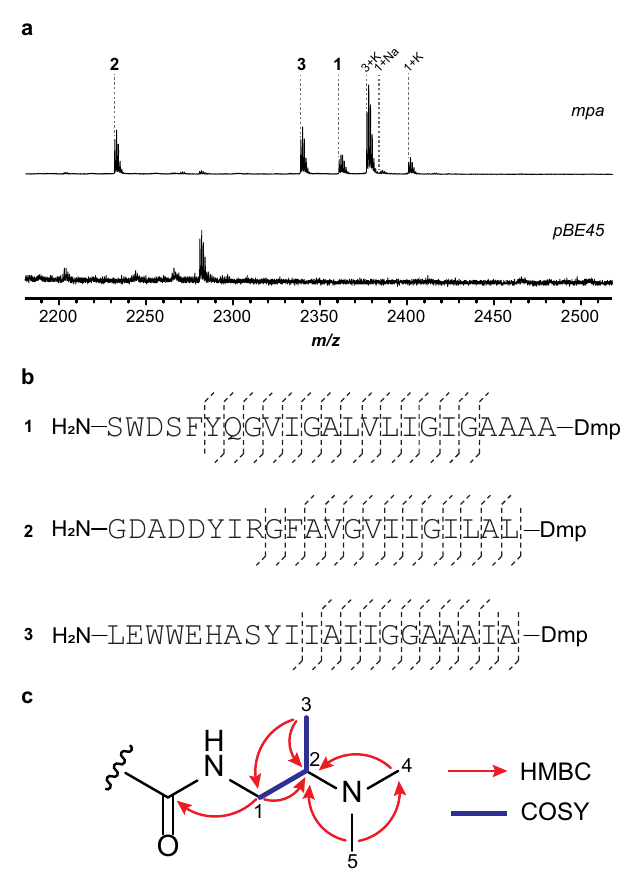
Fig. 2 | Heterologous expression and product characterization of mpa . a MALDI-TOF mass spectra of the methanol extracts of S. albus J1074 containing mpa ( 1 , m/z 2363; 2 , m/z 2232; 3 , m/z 2339) and the pBE45 empty vector. Sodium and potassium ions are denoted as ‘ +Na ’ and ‘ +K ’ . b Summary of the HR-MS/MS results for compound 1-3 . c , key HMBCand COSY correlations for the Dmpmoiety in 1 . NMR spectra of 1 and assigned signals of Dmp are shown in Supplementary Fig. 14 and Supplementary Table 2,